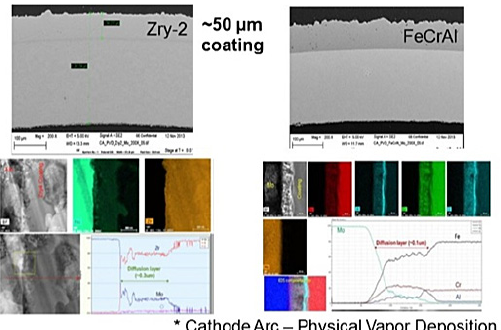
Fig. 4. Cross-section views of Mo tube with 0.2 mm wall thickness coated with a Zircaloy-2 or FeCrAl layer of ∼ 0.05 mm. The pictures at the bottom show the presence of an inter-diffusion layer of 0.3 and 0.1 m m at the interface of the Zircaloy-2 and FeCrAl coating, respectively [10].